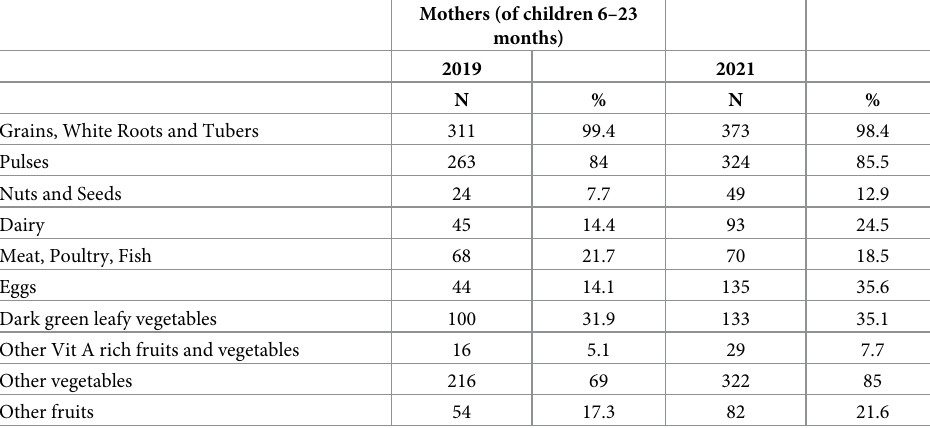
Table 2. Dietary intake from food groups among mothers of children (6–23 months), Gadchiroli and Chandra- pur, 2019 and